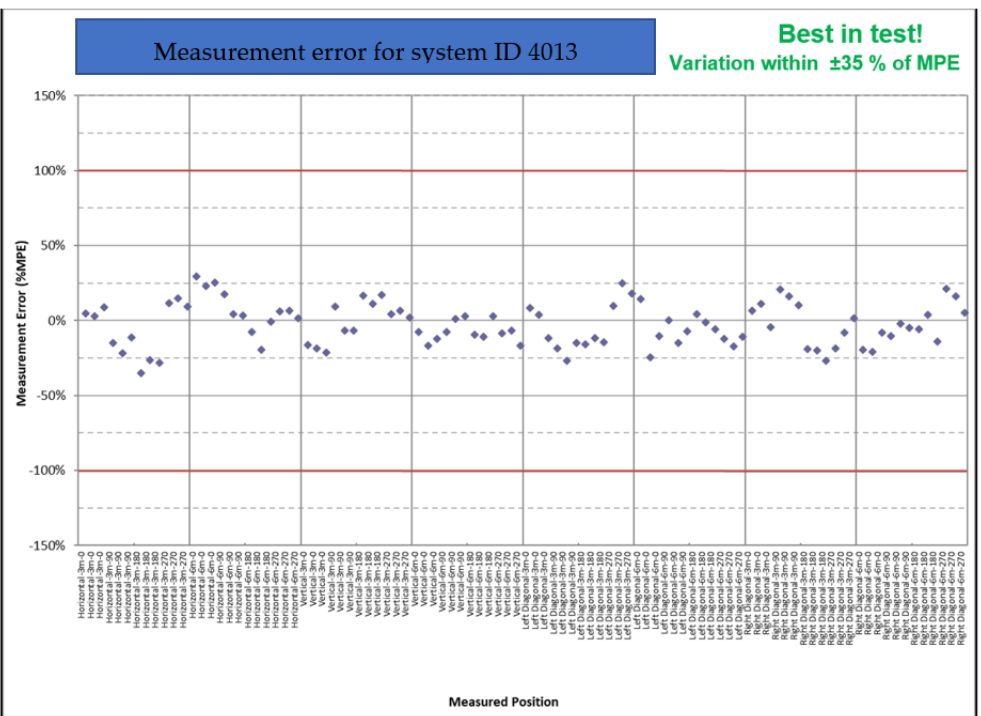
Figure 8. The first verification and calibration performance test and results, Nikon APDIS MV430E Laser Radar, sensor unit ID 4013. The control chart displays measured position of the scalebar as a function of the percentage of the Maximal Permissible Error (%MPE).